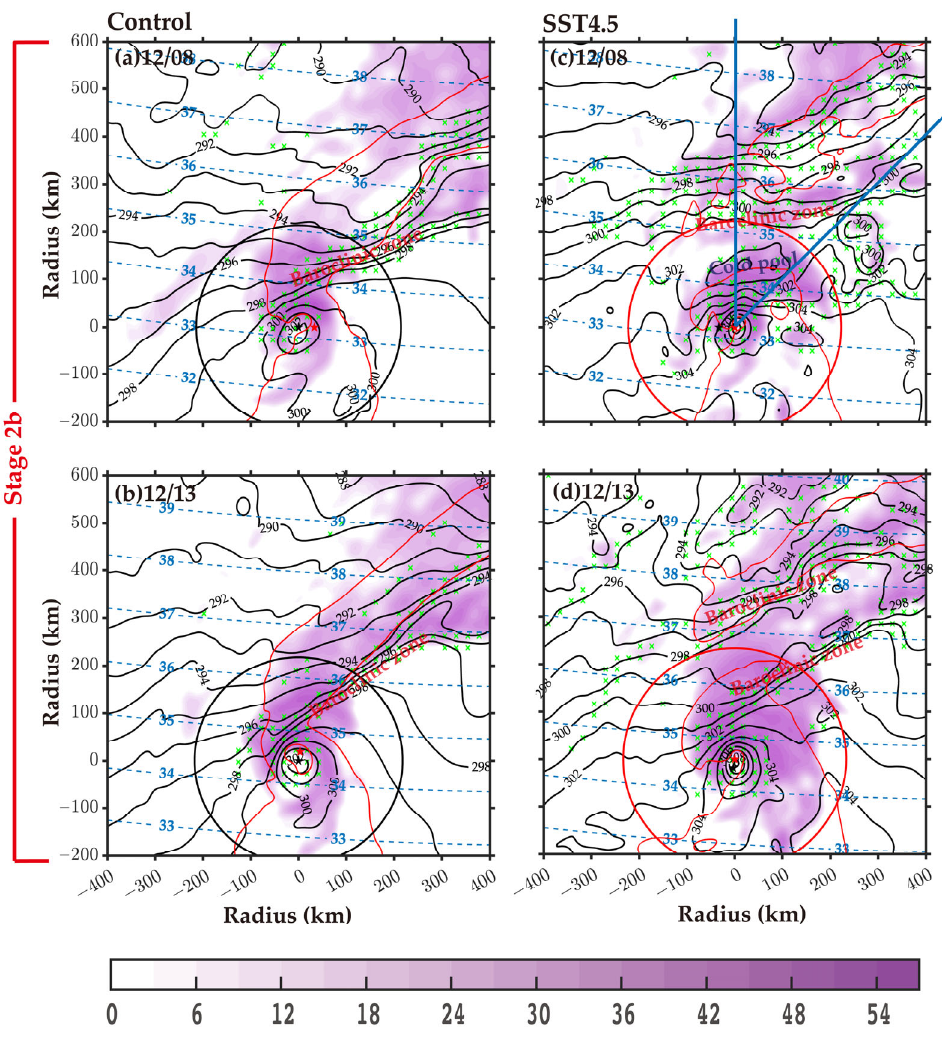
Figure 10. As in Figure 6 but for 12/08 and 12/13 (stage 2b). Two dark blue lines in c indicate the segment over which the variables are azimuthally averaged in Figure 8.